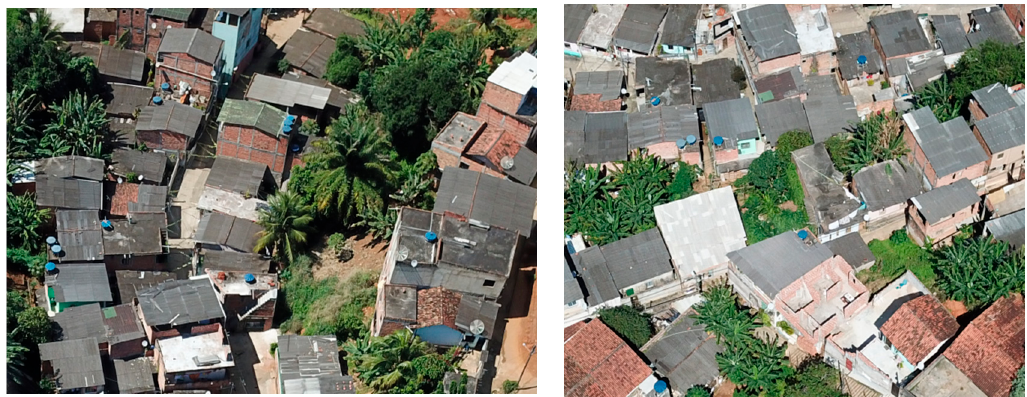
Figure 8. Oblique UAV images of the Alto do Cabrito neighborhood.